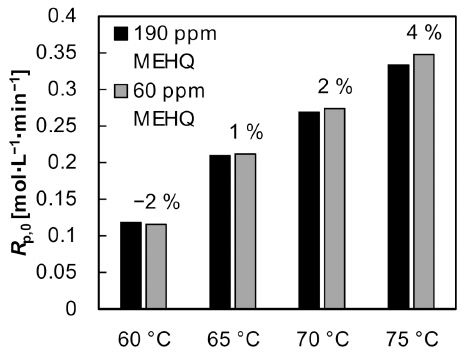
Figure A2. Effect of MEHQ content (measured by HPLC with 40% acetonitrile/60% water at 280 nm with a flow rate of 0.5 mL/min at a column temperature of 50 ◦ C) on the polymerisation of acrylic acid in 2-propanol (150 g/L, 0.5 mol% AIBN) in a nitrogen atmosphere. The percentage values above the bars indicate the respective